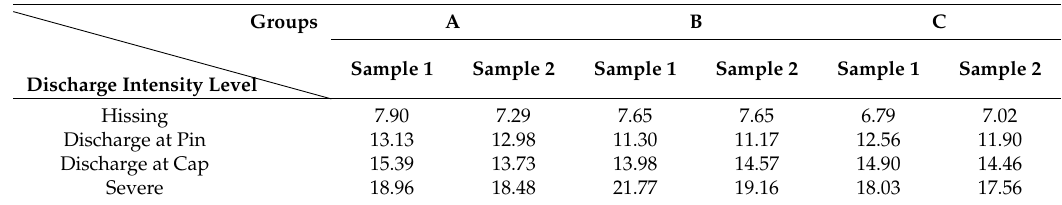
Figure 14. THD for dry insulator condition for samples of: ( a ) Group A; ( b ) Group B; ( c ) Group C. Table 15. Average THD (%) for dry